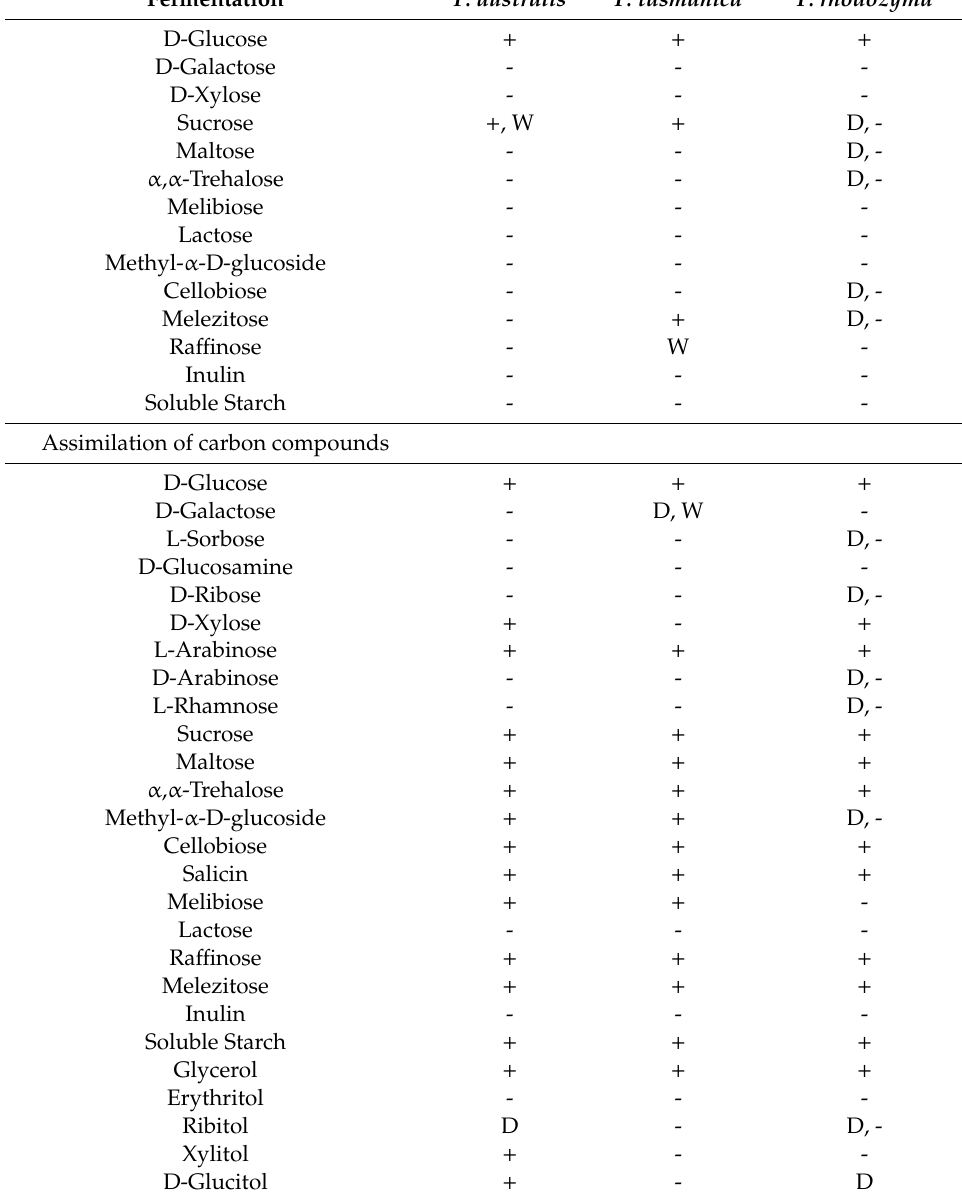
Table 2. Physiological characteristics of P. australis sp. nov. PYCC 6859 T , PYCC 6943 and PYCC 6944, P. tasmanica sp. nov. PYCC6858 T , PYCC 6947 and PYCC 6948, and comparison with P. rhodozyma